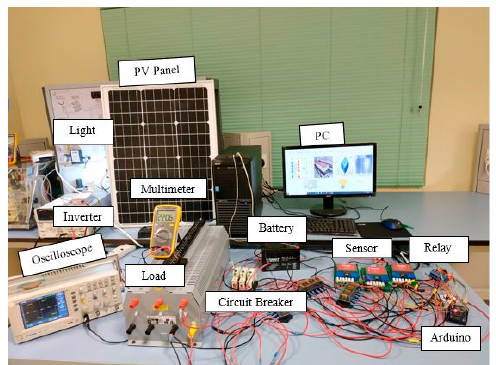
Figure 11. Experimental hardware setup of the proposed model.